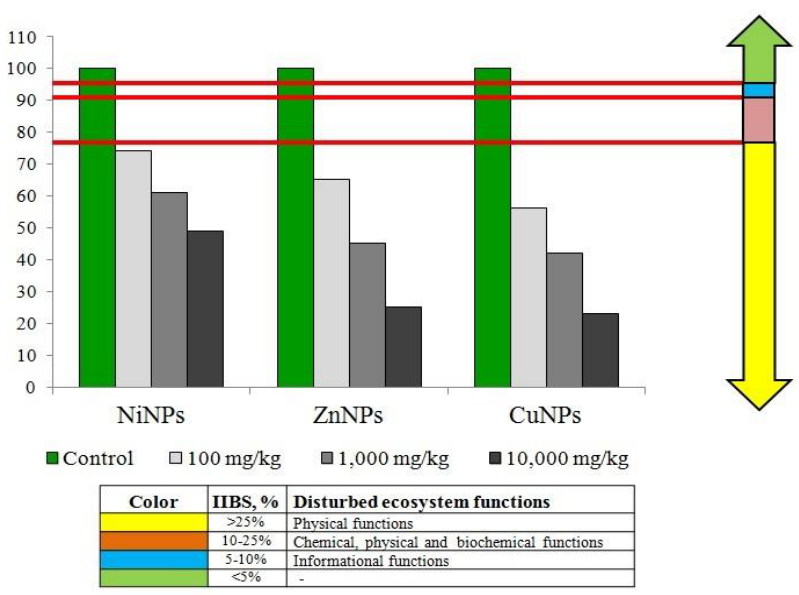
Figure 5. Change in IIBS of Cambisols by Cu, Ni, and Zn NPs pollution, % of control.